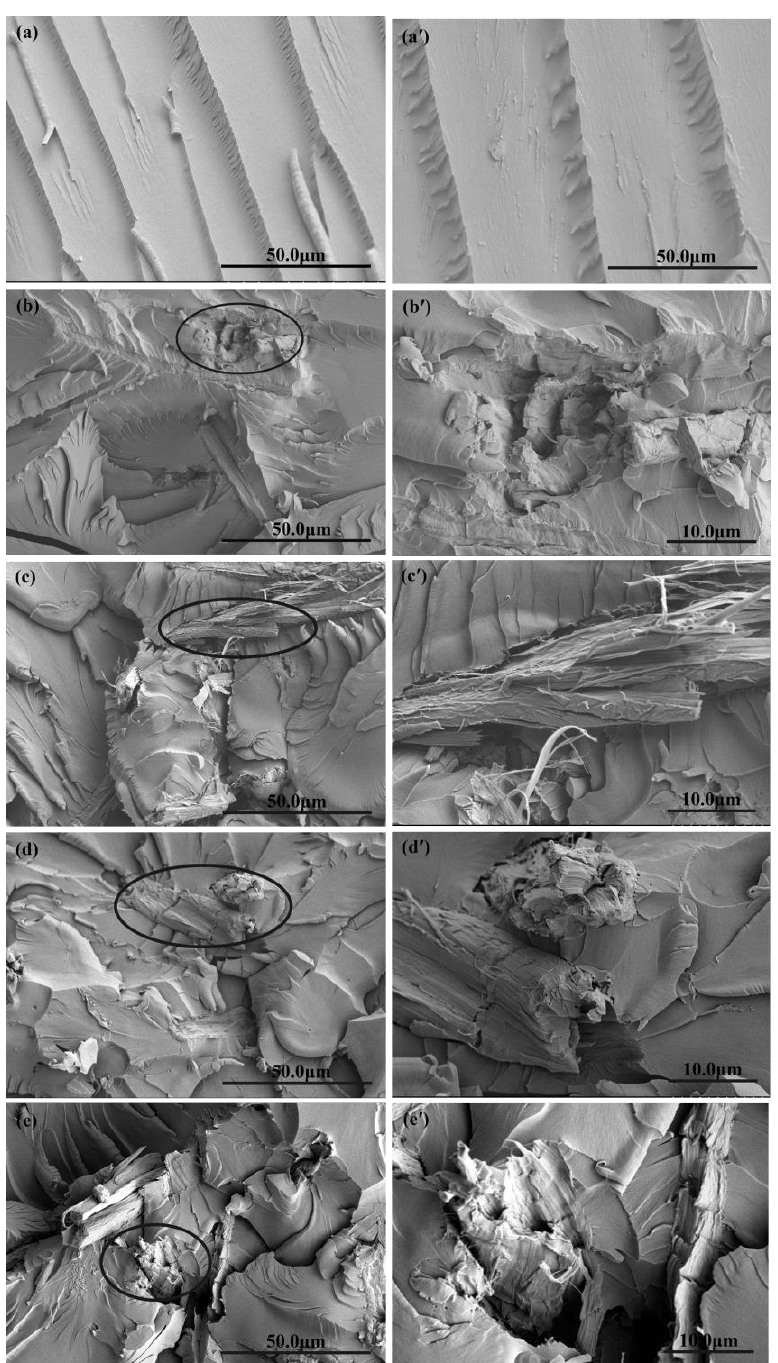
Figure 9. SEM images of fractured surface: ( a , a′ ) neat epoxy, and SCFs-HLP/EP composites: ( b , b′ ) 1.0 wt %, ( c , c′ ) 3.0 wt %, ( d , d′ ) 4.0 wt %, and ( e , e′ ) 5.0 wt %.